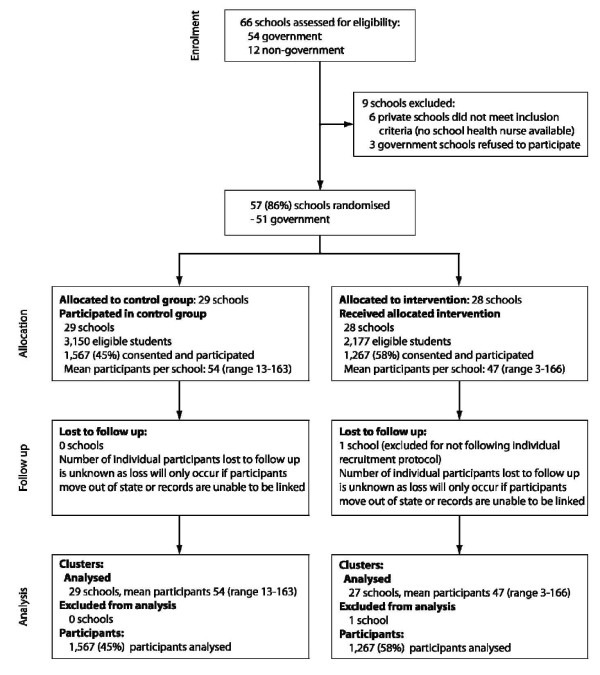
Participant Flow